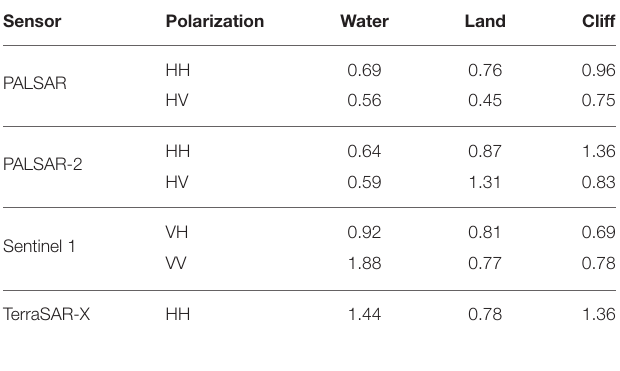
TABLE 2 | Standard deviation of absolute residuals for water, land and cliff for each satellite and polarization ( σ 0 in dB) for use in equation 3 and 4.